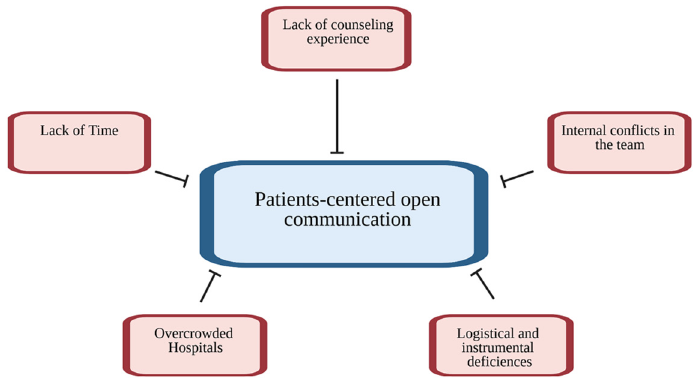
Figure 1. Major barriers for patient-centered care.